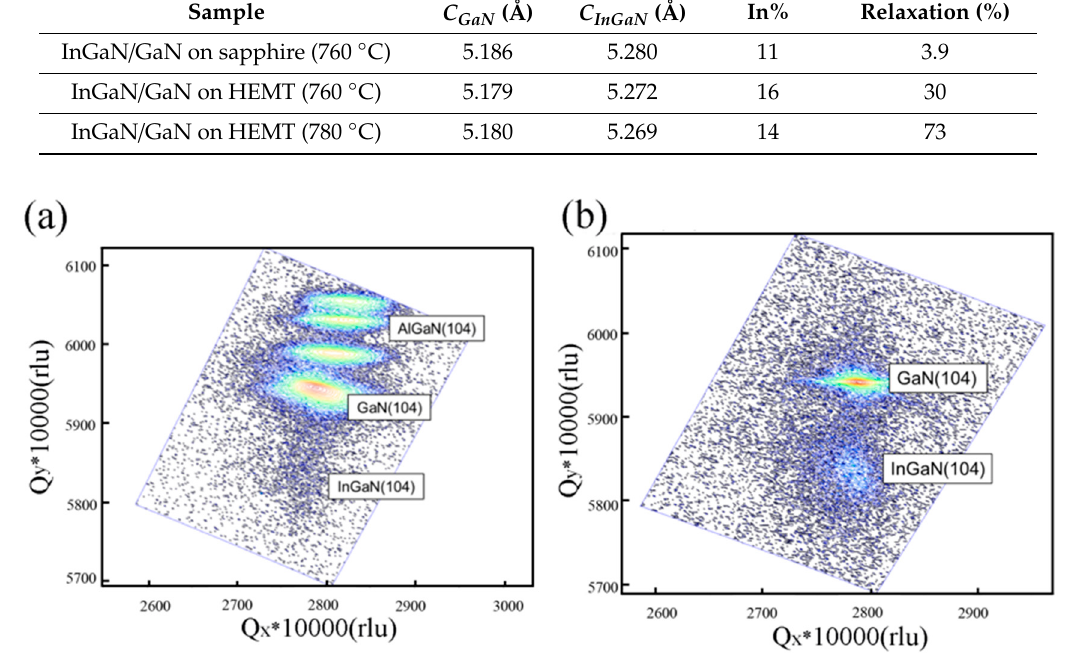
Figure 3. XRD reciprocal space mapping of (104)-plane for InGaN/GaN heterostructures at the temperature of 760 °C both on the ( a ) AlGaN/GaN-on-Si HEMT and ( b ) GaN/sapphire template.